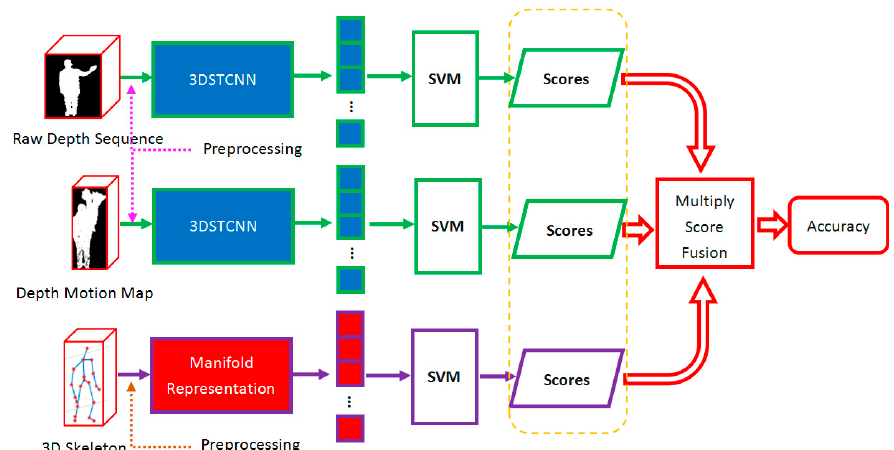
Figure 1. Flowchartoftheentirefusionframework. (3DSTCNNinblueblocksstandsfor3Dspatial-temporal Figure 1. Flowchart of the entire fusion framework. (3DSTCNN in blue blocks stands for 3D convolutional neural spatial-temporal convolutional neural networks.).